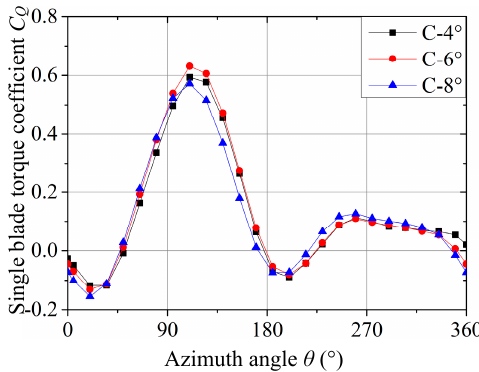
Figure 13. Torque coefficients acting on the single blade obtained from CFD simulations at different pitch angles of β = 4°, 6°and 8° , respectively.